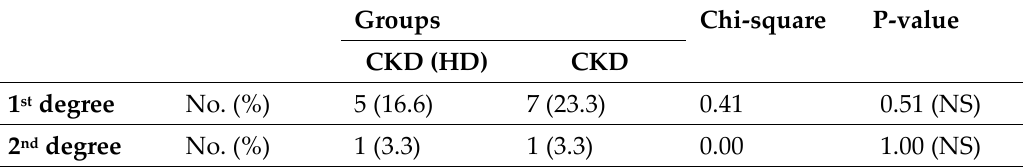
Table 3: Family history of chronic kidney disease patients.